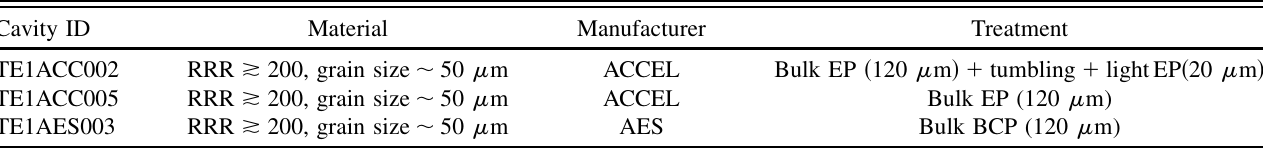
TABLE I. List of cavities used for